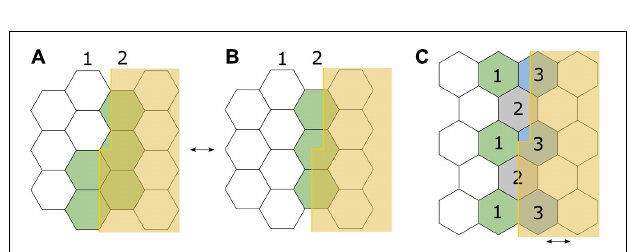
FIGURE 3 | A comparison between the concepts of visual acuity and vernier acuity using a hexagonal mosaic model of retinal photoreceptors. Yellow circles with blurred edges represent areas of retinal illumination. Classical visual acuity, or resolution acuity (R), involves resolving two stimuli as separate and requires a gap in retinal illuminance to be detected by a photoreceptor located between other photoreceptors receiving stimulation. Vernier acuity (V) involves localisation of the difference in spatial positions of two separate stimuli.